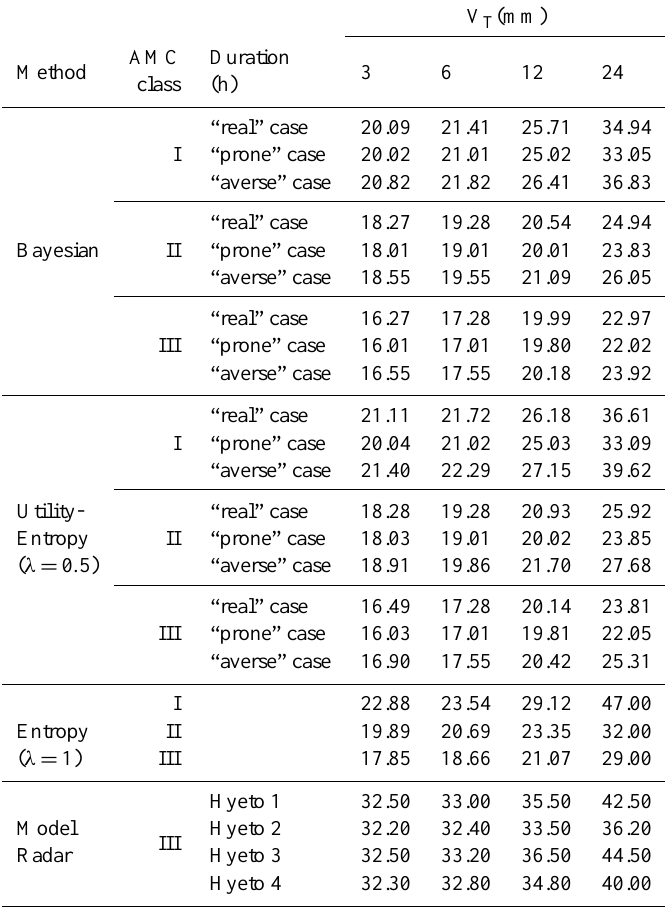
Table 4. Threshold values evaluated by each method for the Mignone river